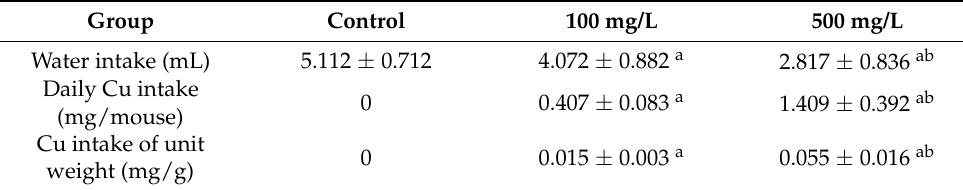
Table 1. Analysis of water and Cu intake in mice.